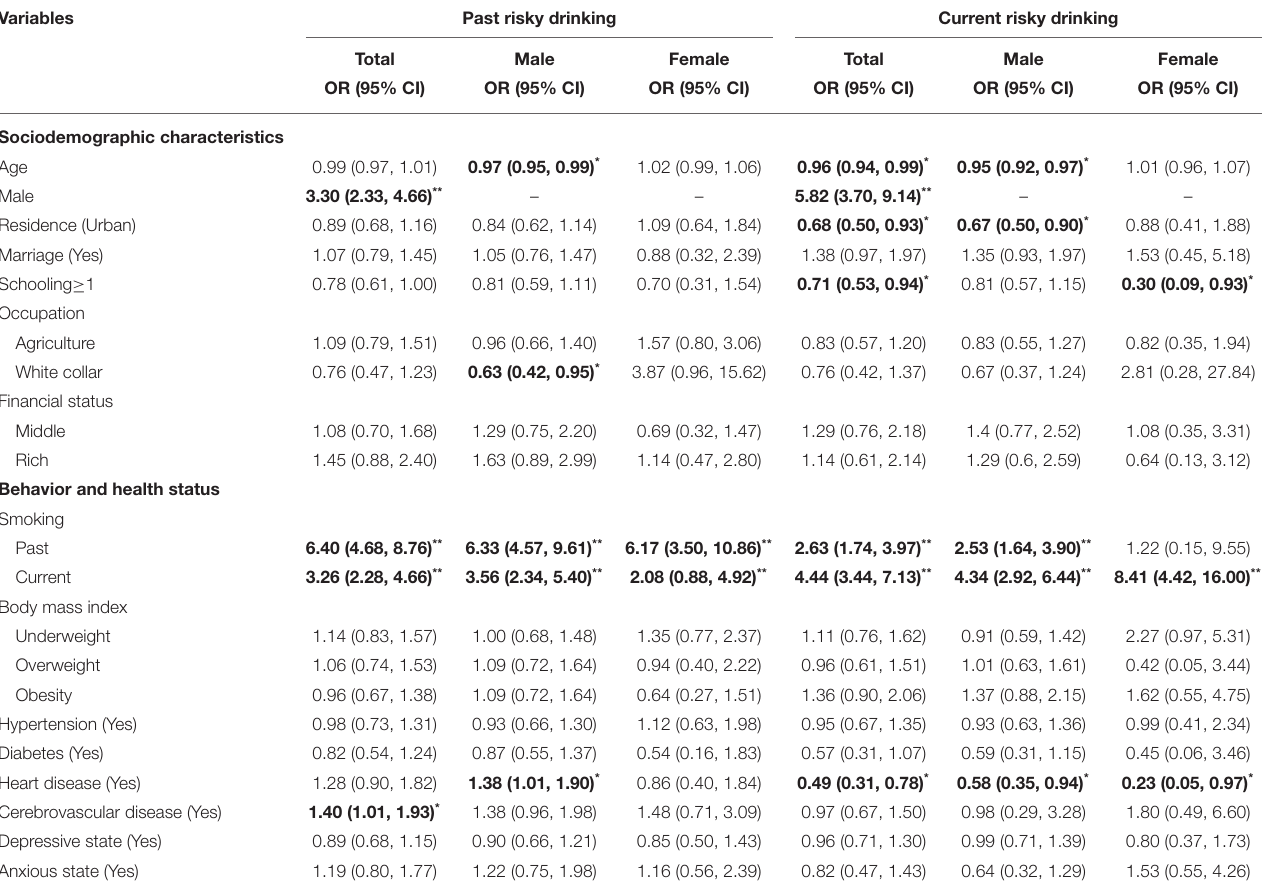
TABLE 4 | Association between related factors and risky drinking in whole sample and different sex ( n = 10,141).